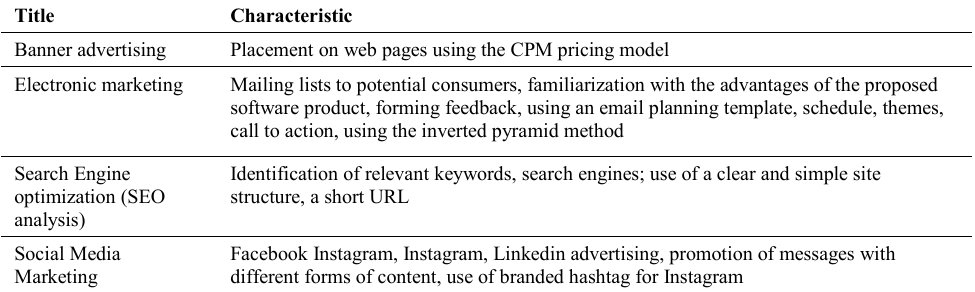
Placement on web pages using the CPM pricing model